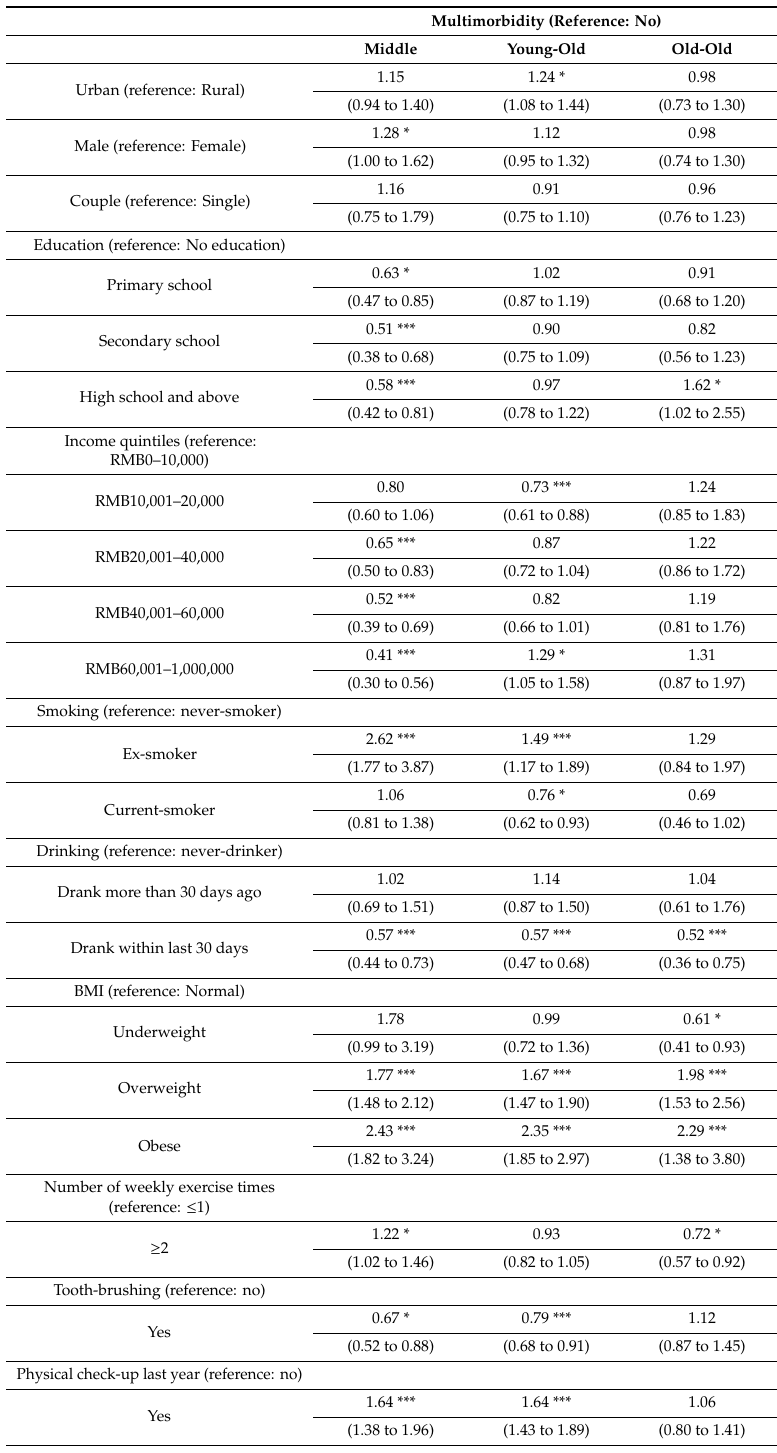
Table 3. The association of lifestyle factors with multimorbidity by age groups (odds ratio (OR), 95% confidence interval